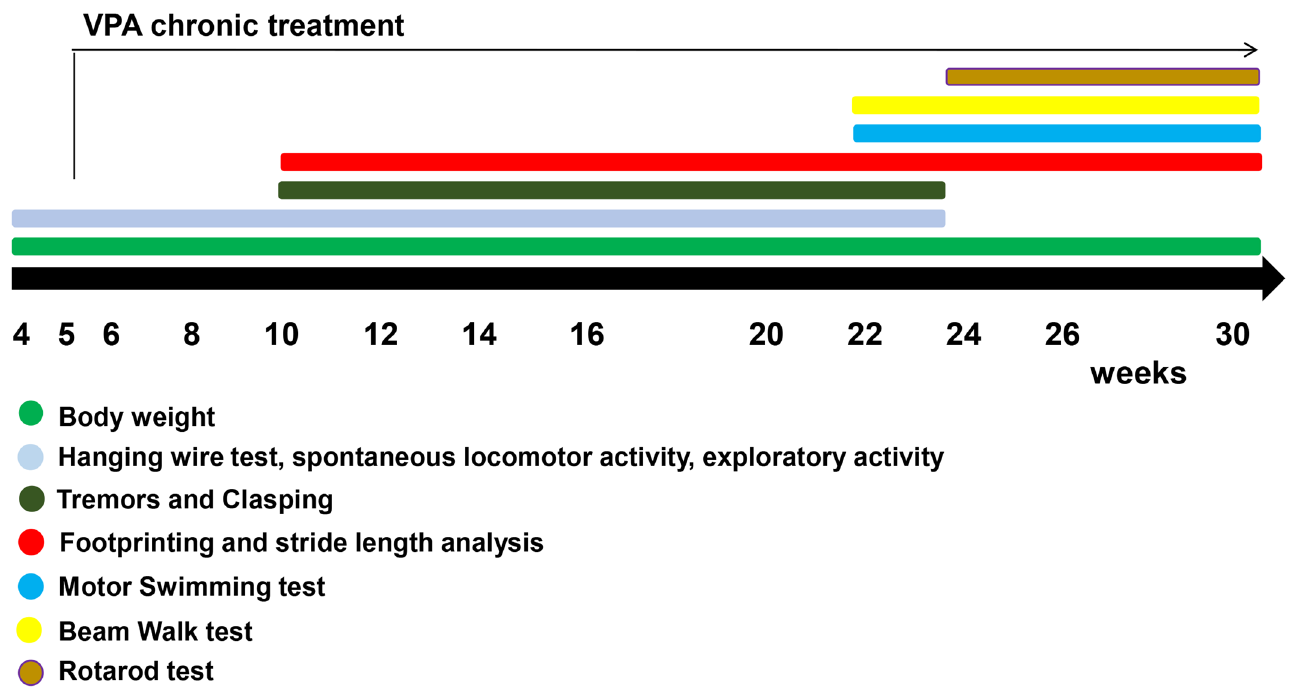
Fig 2. Schematic representation of the VPA pre-clinical therapeutic